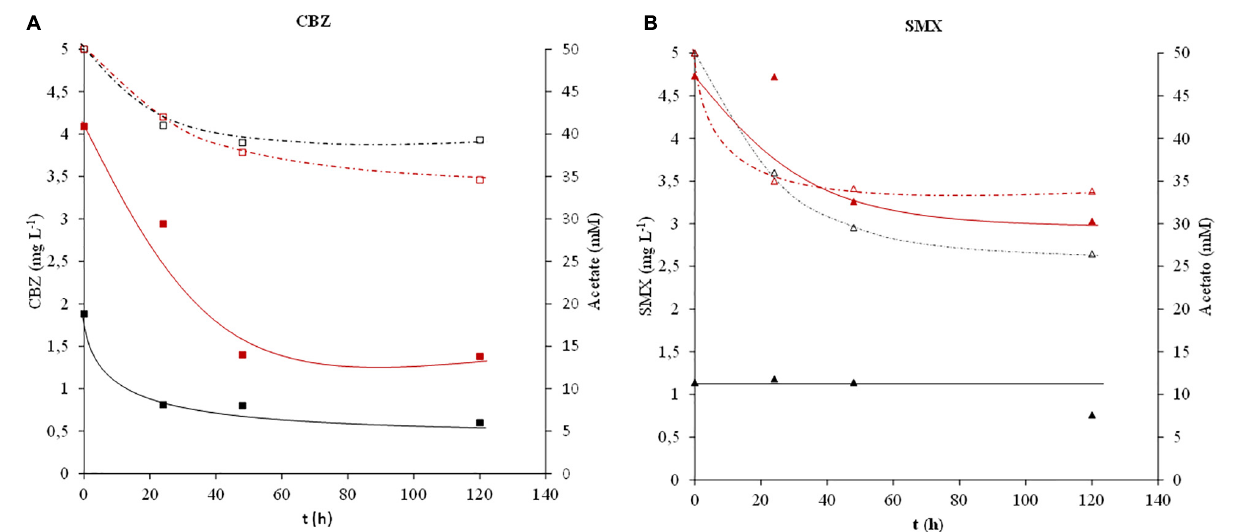
FIGURE 1 | CBZ and SMX removal capacity of the anaerobic consortium. (A) CBZ removal capacity: (cid:3) acetate concentration in synthetic wastewater polluted with ∼ 4 mg L − 1 CBZ, (cid:3) acetate concentration in synthetic wastewater polluted with ∼ 2 mg L − 1 CBZ, (cid:4) CBZ concentration in 4 mg L − 1 CBZ-polluted synthetic wastewater, (cid:4) CBZ concentration in 2 mg L − 1 CBZ-polluted synthetic wastewater. (B) SMX removal capacity: (cid:52) acetate concentration in synthetic wastewater polluted with ∼ 4.7 mg L − 1 SMX, (cid:52) acetate concentration in synthetic wastewater polluted with ∼ 1 mg L − 1 SMX, (cid:78) SMX concentration in ∼ 4.7 mg L −